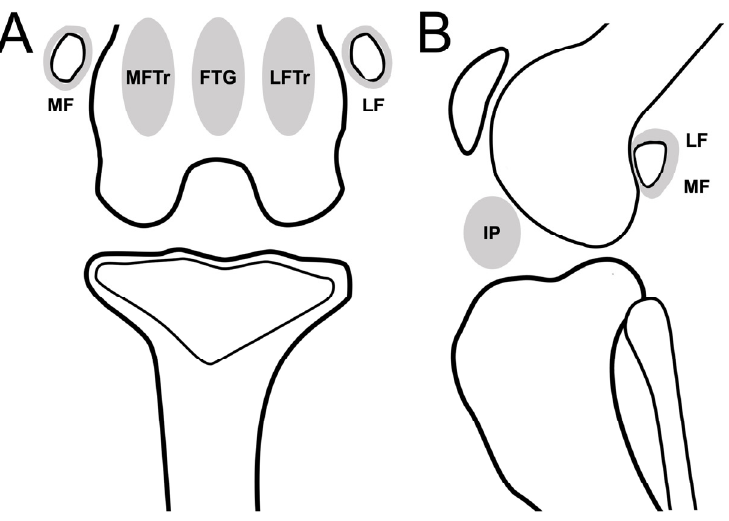
Figure 2. Schematic representation of stifle joint anatomic compartments for evaluating synovial effusion in the dorsal plane (CT or MRI)/caudocranial view (DR) ( A ), and sagittal plane (CT or MRI)/mediolateral view (DR) of stifle joint ( B ). Stifle joint is divided into 6 subregions to evaluate synovial effusion. Abbreviations: FTG, femoral trochlear groove; IP, infrapatellar region; LF, lateral fabella; LFTr, lateral femoral trochlear ridges to epicondyle region; MF, medial fabella; MFTr, medial femoral trochlear ridges to epicondyle region.